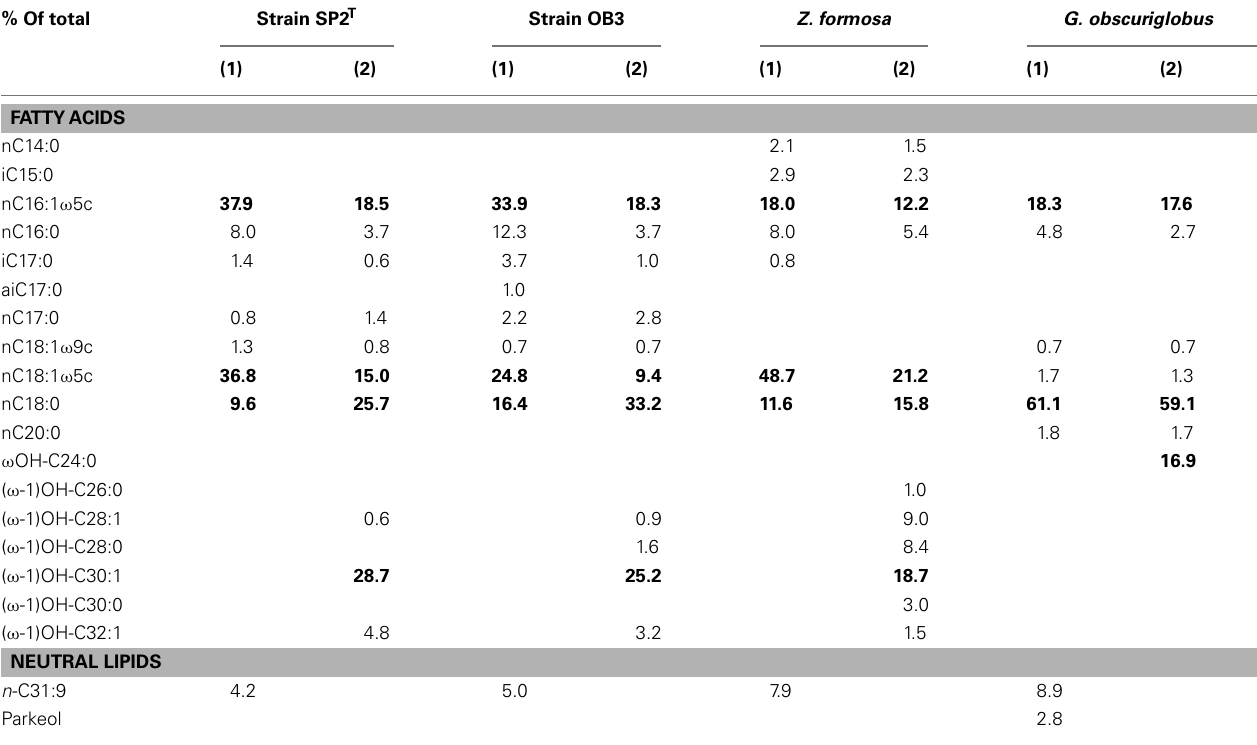
Table 2 | PLFA and neutral lipid composition of strains SP2 T , OB3, Zavarzinella formosa A10 T , and Gemmata obscuriglobus DSM 5831 T (major PLFAs are shown in